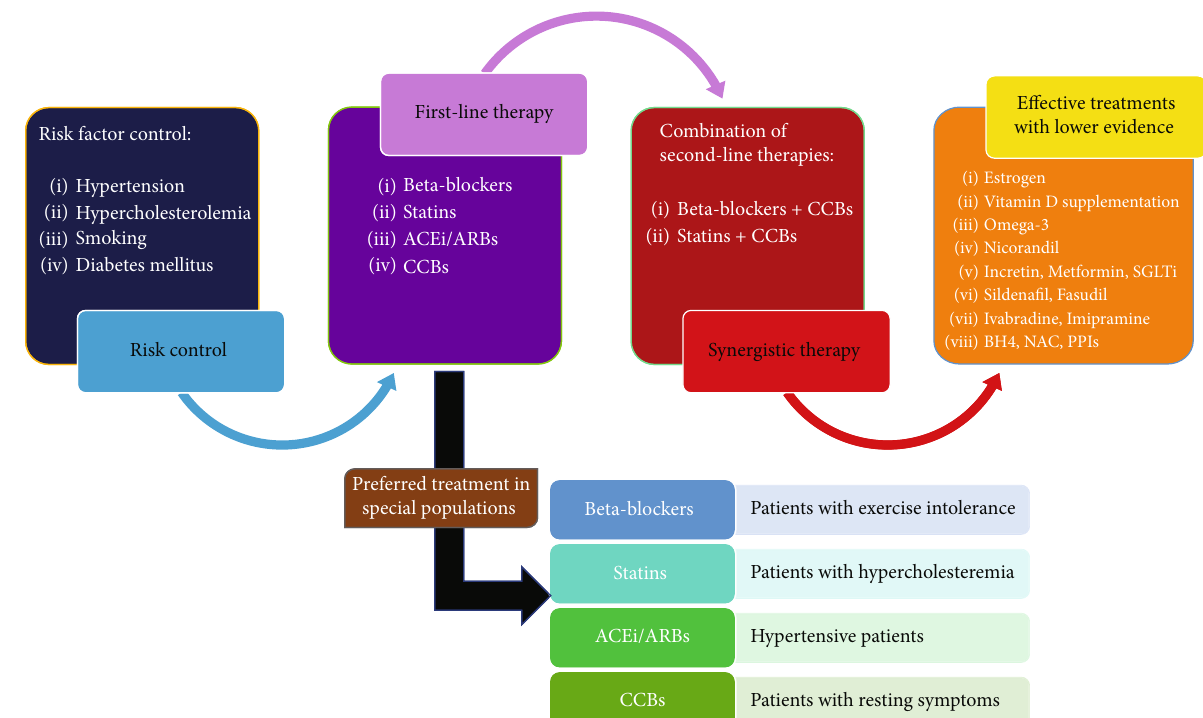
Figure 2: Proposed pharmacologic management algorithm for patients with microvascular angina.